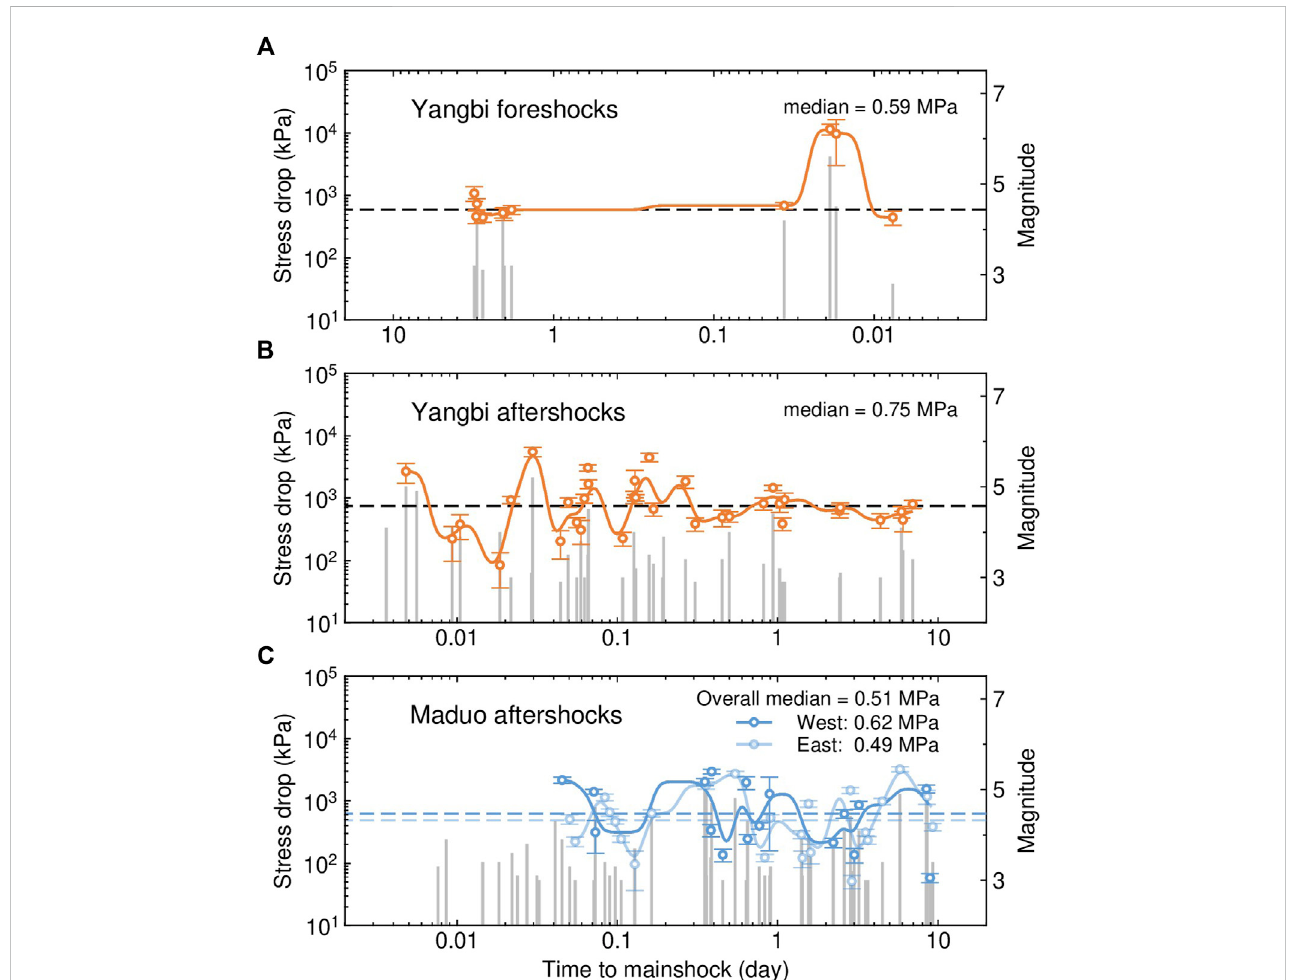
FIGURE 8 Temporal variations in the stress drop for the (A) Yangbi foreshock sequence, (B) Yangbi aftershock sequence and (C) Maduo aftershock sequence. The stress drop estimates are represented by open circles. Solid trendlines are obtained by applying a low-pass Gaussian fi lter. The seismicity of earthquakes with magnitudes greater than 3.0 is shown by vertical gray lines, with their heights corresponding to magnitudes. Error bars indicate the standard deviations of stress drops measurements, with their stress drop values indicated by dashed lines. Aftershocks in Maduo sequence are grouped according to their locations east (light blue) or west (blue) to the